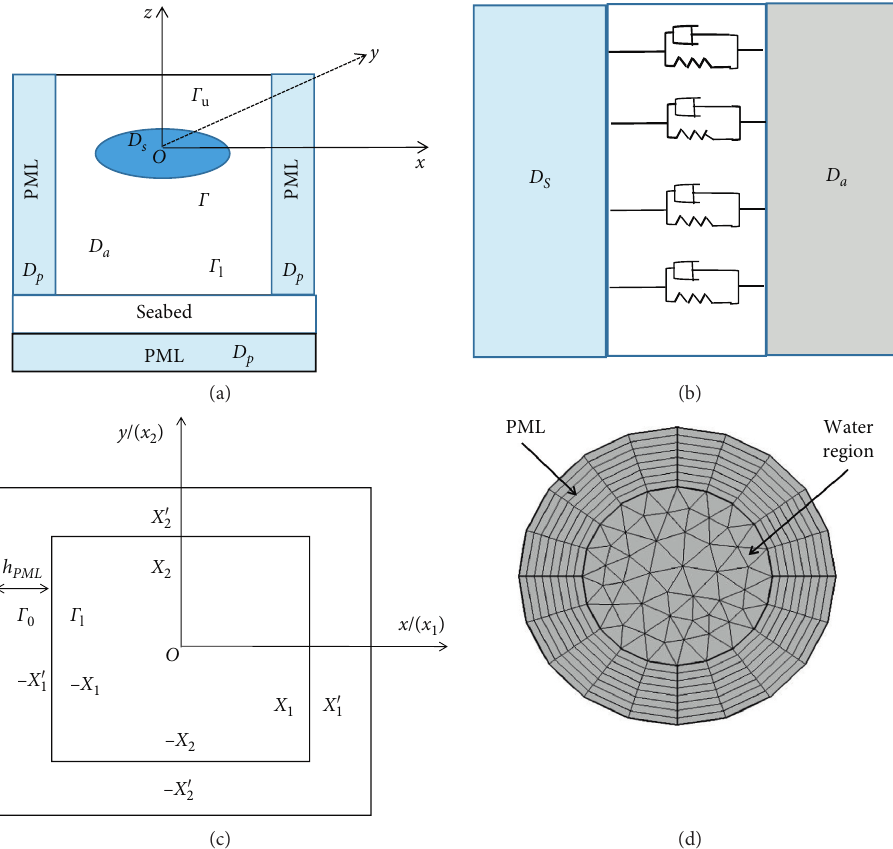
Figure 3: (a) The numerical model of multiphysical field with an elastic structure in a shallow water waveguide. (b) Fluid-solid coupling model. (c) The model of acoustic perfectly matched layer. (d) FEM area from the XY